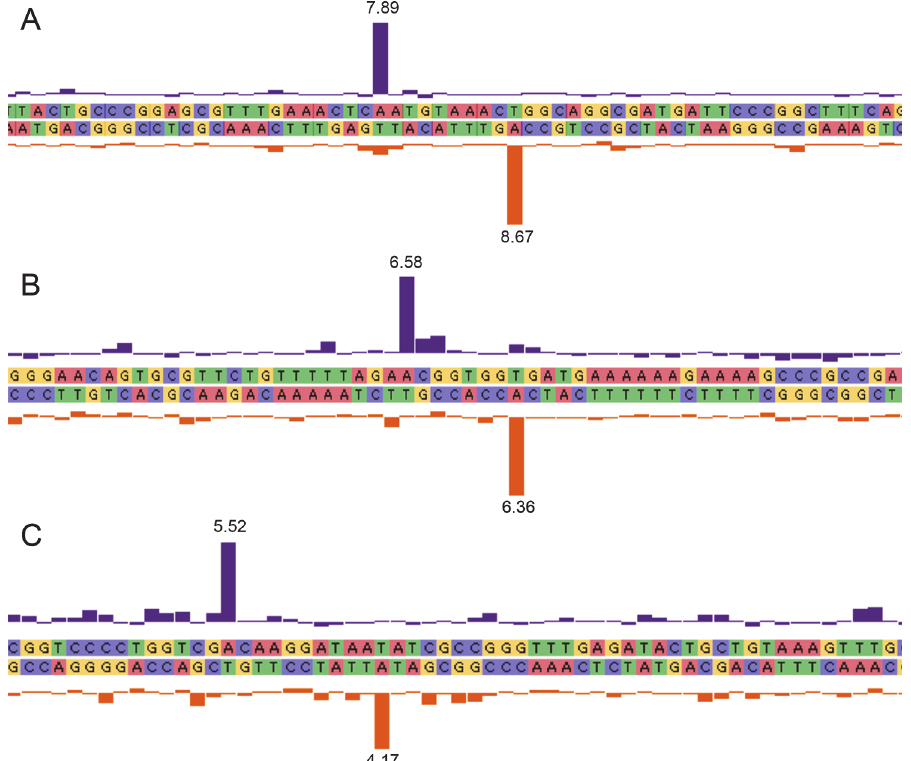
Fig 2. Diagram of the interpulse duration (IPD) ratio of three novel motifs identified in three Salmonella serovars. Vertical axis = IPD ratio, horizontal axis = genome position. IPD ratio listed next to bar. A. Motif CC m6 AN 8 TGAG in S . Anatum. B. Motif RA m6 ACN 5 TGA in S . Cubana. C. Motif CG m6 AYN 6 RTRTC in S .